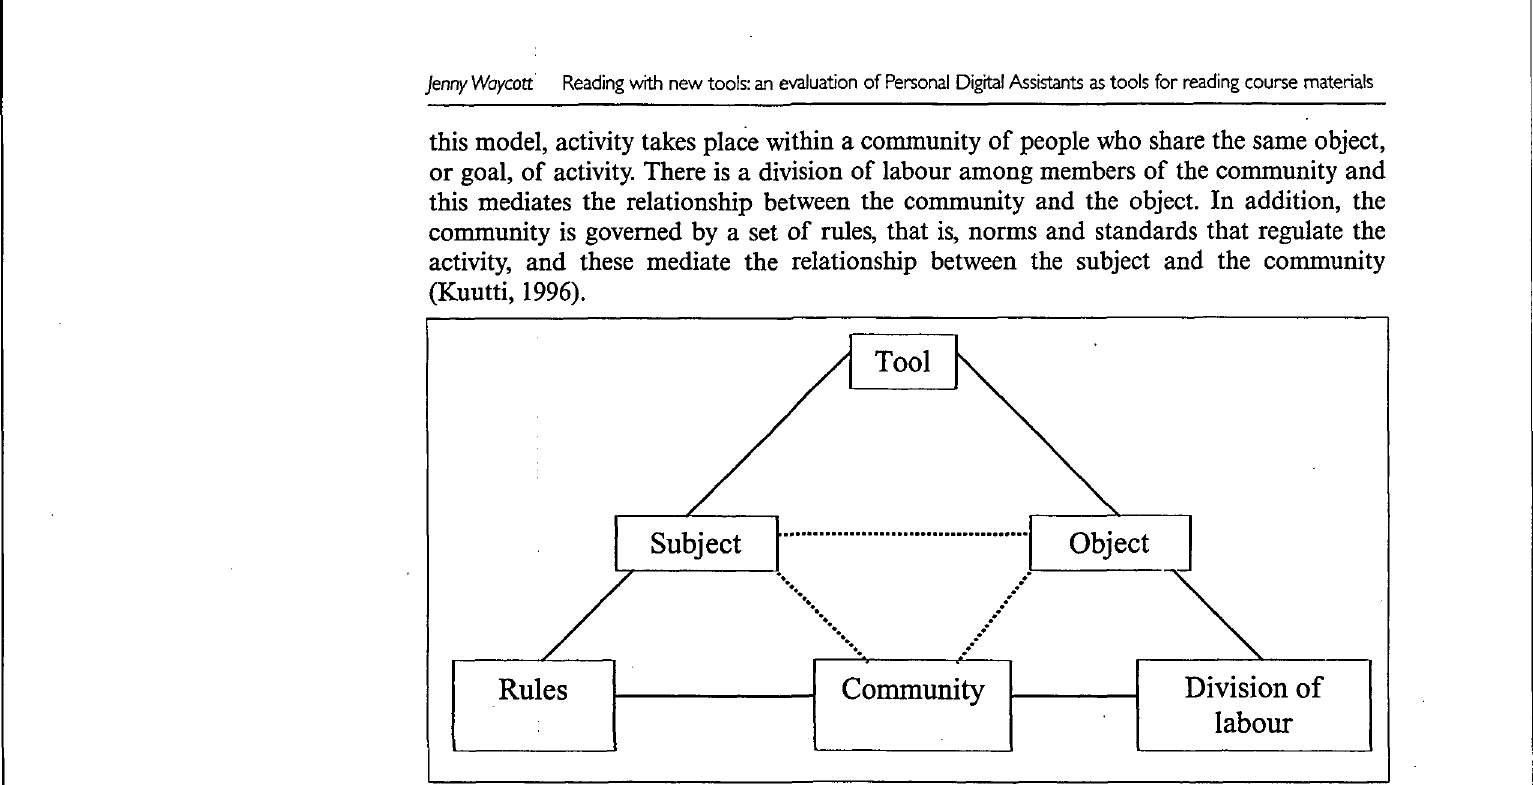
Figure I: Activity triangle model (from Engestrom,